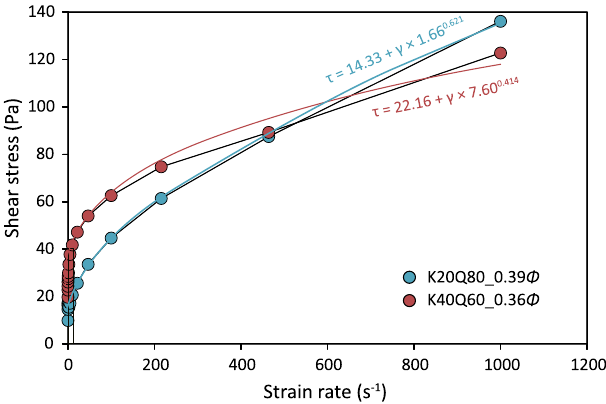
Figure 1. Typical flow curves for kaolinite–quartz suspensions without